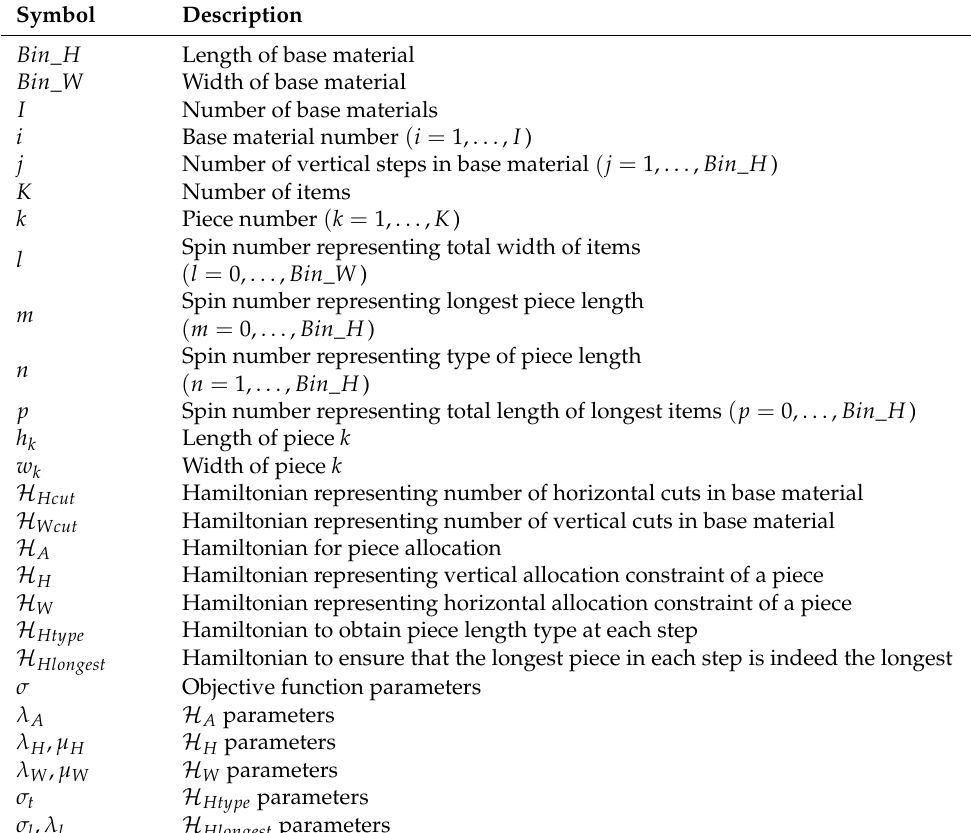
Table 1. List of variables.